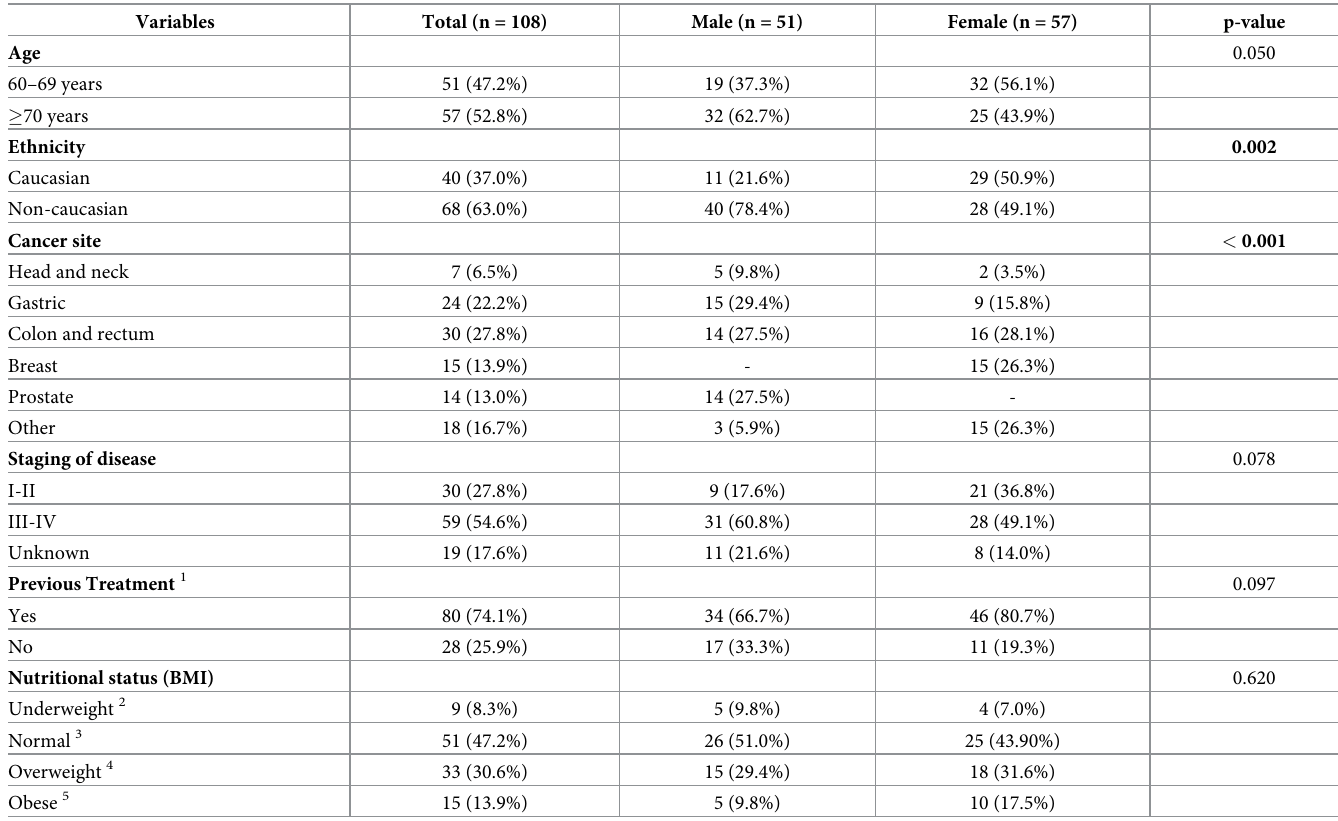
Table 1. General characteristics of cancer patients according to